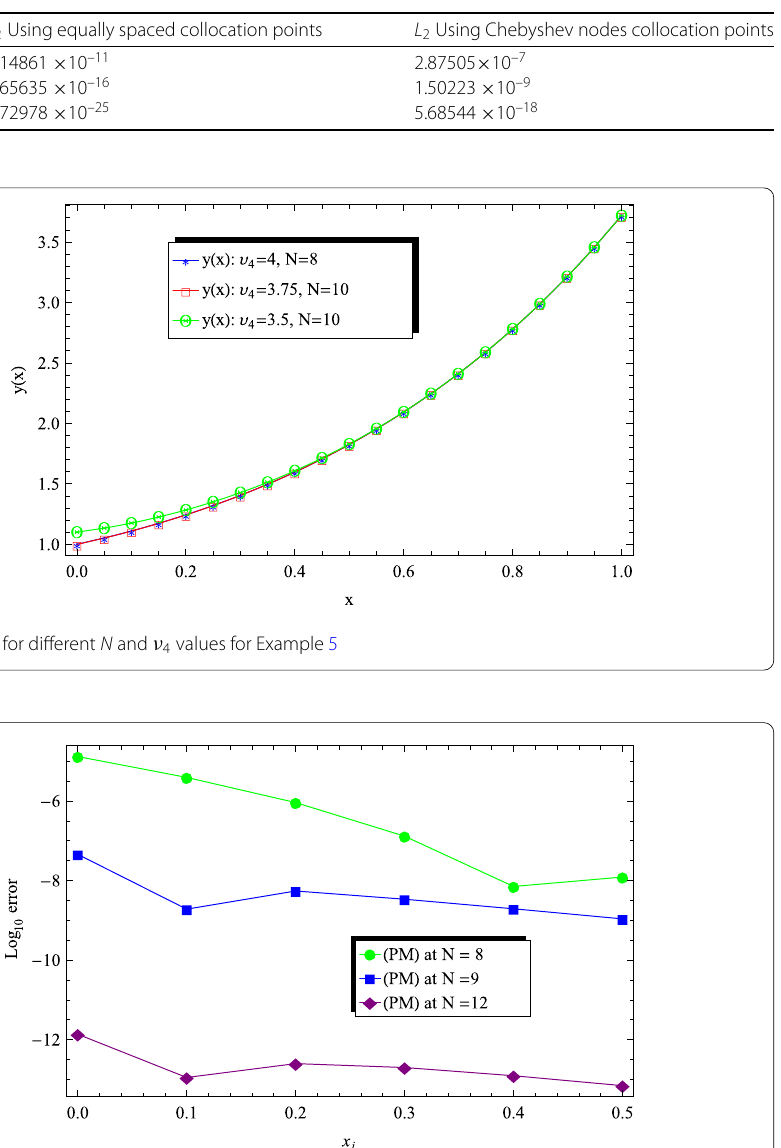
Table 10 Comparison of the L 2 error norm for Example 5 using both equally spaced and Chebyshev nodes collocation points